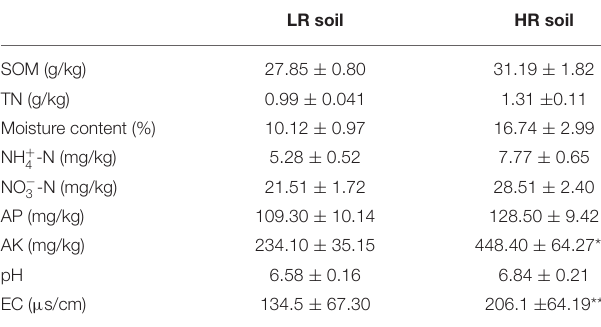
TABLE 1 | Basic physicochemical properties of